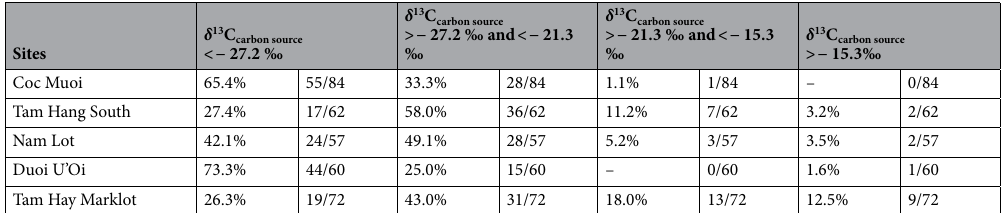
Table 1. Percentage (%) and number of specimens (n/N) in the five faunas according to the distribution of δ 13 C carbon source values (‰ VPDB) from the oldest (top) to the youngest (bottom). Closed-canopy forests ( δ 13 C carbon source < − 27.2 ‰); intermediate rainforests and woodland biomes ( δ 13 C carbon source > − 27.2 ‰ and < − 21.3 ‰); no specific ecological environment ( δ 13 C carbon source > − 21.3 ‰ and < − 15.3 ‰); and savannah- like environments ( δ 13 C carbon source > − 15.3‰).